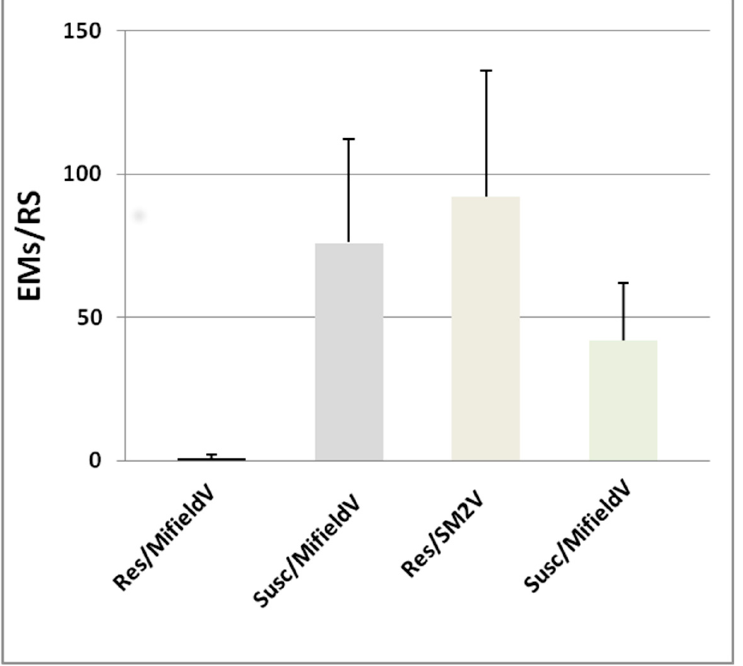
Figure 1. Numbers of egg masses per root system (EMs/RS) in tomato resistant (Res) and susceptible (Susc) plants inoculated with an avirulent ( MifieldV ) and a lab-selected virulent ( SM2V ) M. incognita population .